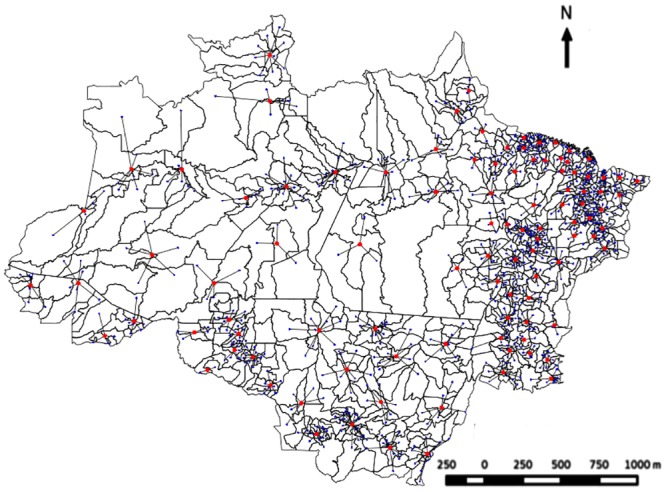
Supermunicipalities of the Brazilian Amazon.Sites for municipalities (blue dots), and supermunicipalities (red dots) formed after grouping.